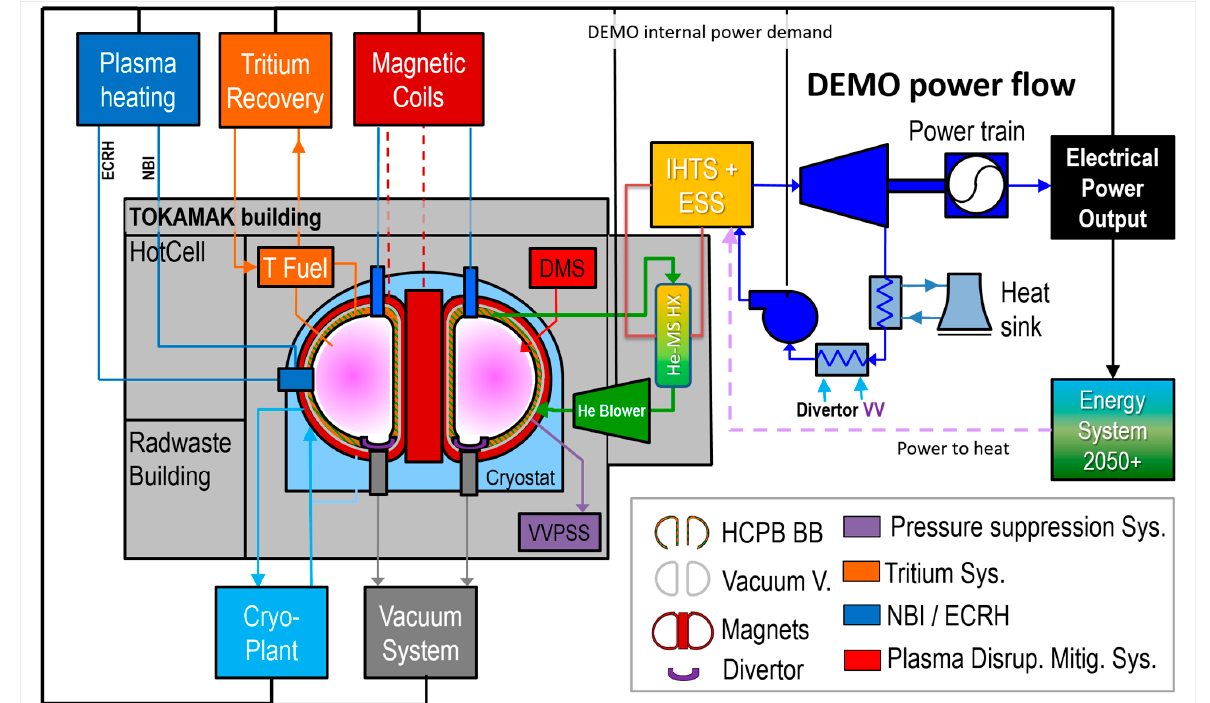
Figure 1. Overview and interfaces of DEMO systems (selected variant HCPB BOP ICD).